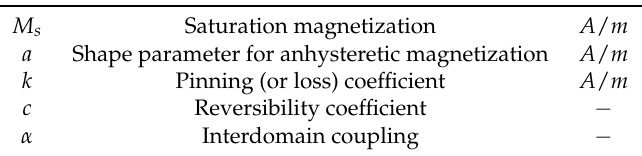
Table 1. Jiles-Atherton model